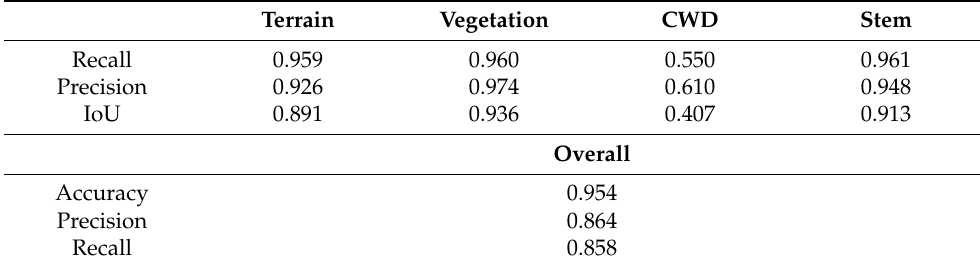
Table 3. Semantic segmentation results.